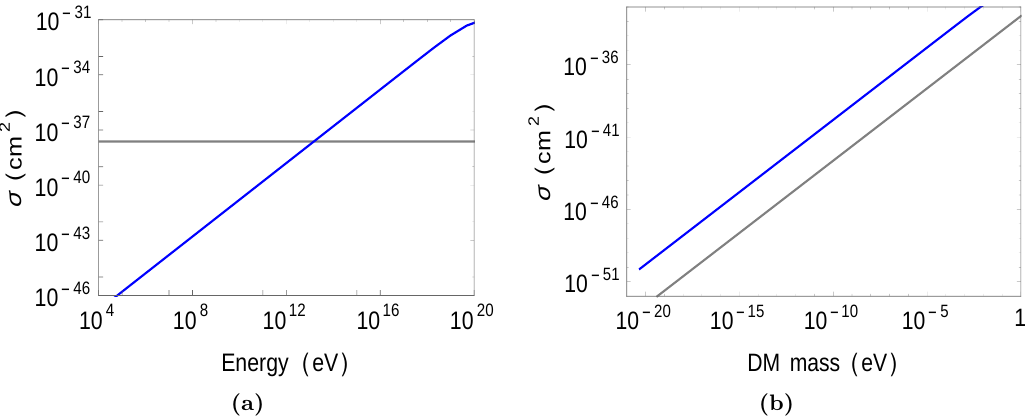
Figure 8. Vector-mediated neutrino-DM scattering. (a) Cross-section vs. incoming neutrino en- ergy. (b) Cross-section vs. mass of DM. Blue and grey lines represent the calculated cross-section and required cross-section to induce 1% suppression of incoming (cid:13)ux respectively. Here, the medi- ator mass m Z 0 = 10 MeV, and the couplings g 0 f 0 = 10 (cid:0) 3 . For (a), m DM = 10 (cid:0) 6 eV and for (b), the energy of incoming neutrino E (cid:23) = 1